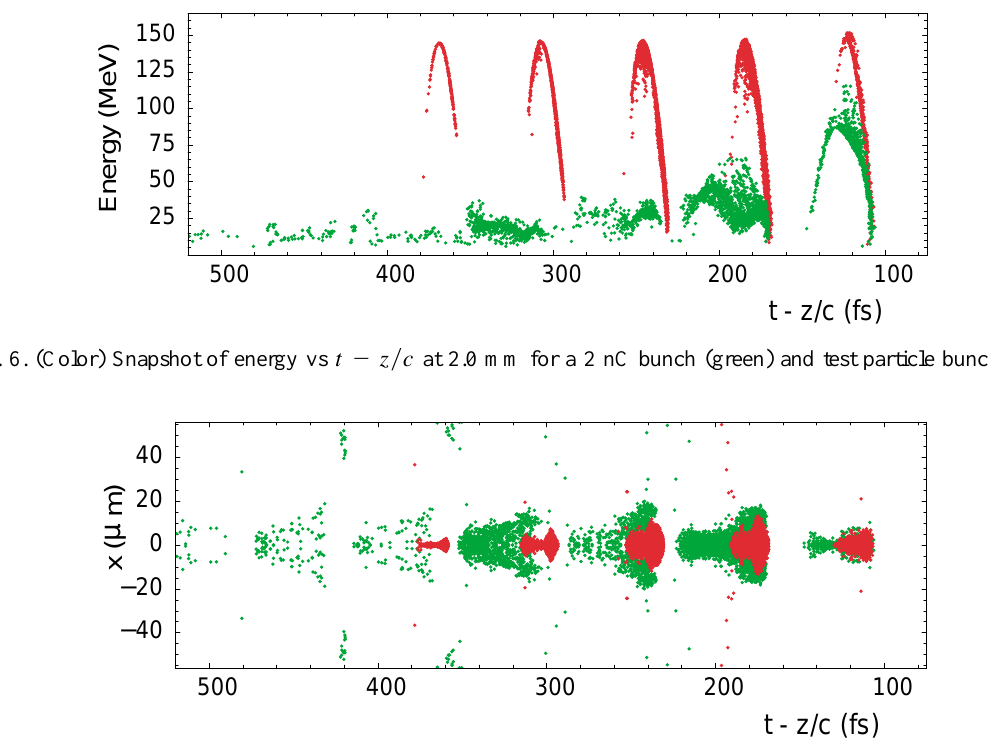
FIG. 7. (Color) Real space snapshot at 2.0 mm for a 2 nC bunch (green) and test particle bunch (red).